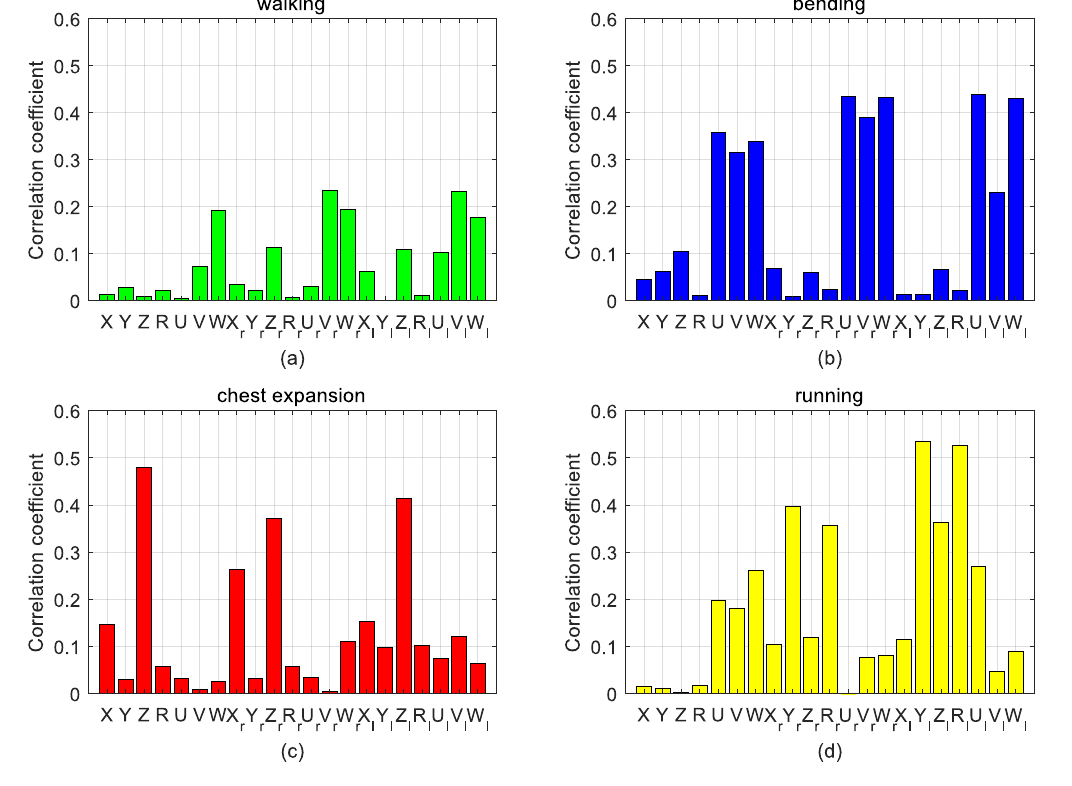
Figure 4. Bar graphs of the correlation coefficients.